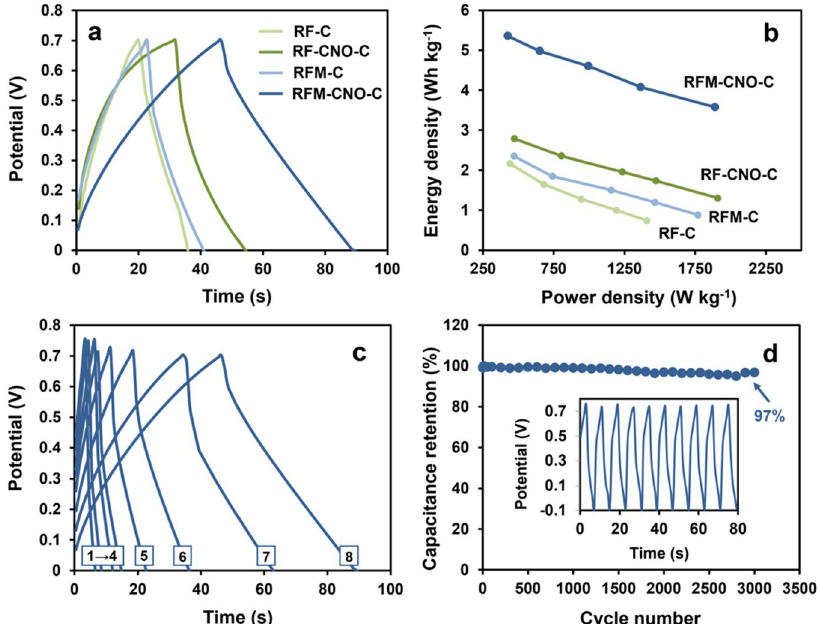
Figure 10. GCD measurements were performed in a two-electrode configuration. ( a ) GCD curves of selected materials recorded in 0.1 M KOH at the current density of 2 A g −1 . ( b ) Ragone plots for selected materials. ( c ) GCD curves of RFM-CNO-C recorded in 0.1 M KOH at the different current densities: (1) 9; (2) 8; (3) 7; (4) 6; (5) 5; (6) 4; (7) 3; and (8) 2 A g −1 . ( d ) Capacitance retention as a function of cycle number for RFM-CNO-C in 0.1 M KOH at the current density of 9 A g −1 . Inset: First 10 galvanostatic GCD cycles recorded for RFM- CNO-C .